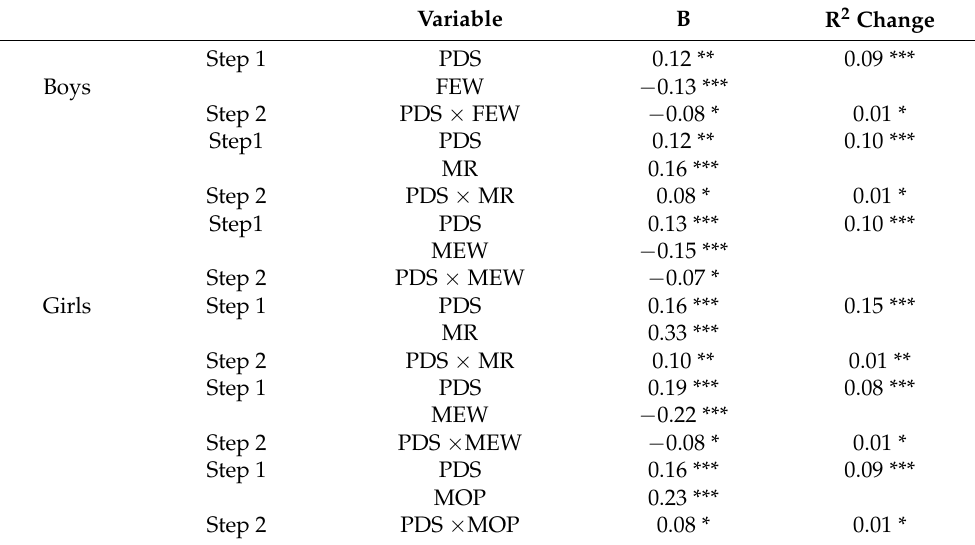
Table 4. Regression analyses testing parenting styles as moderators of the relation between pubertal timing and drinking